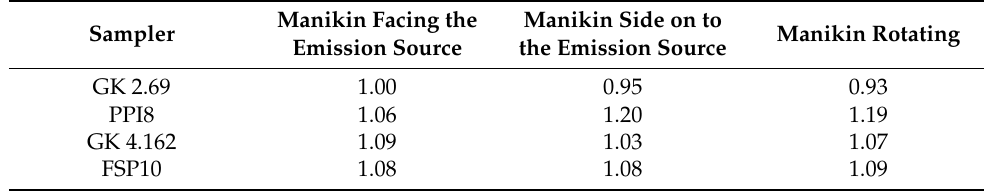
Table 3. Respirable dust concentrations ratio when compared with a SIMPEDS sampler.